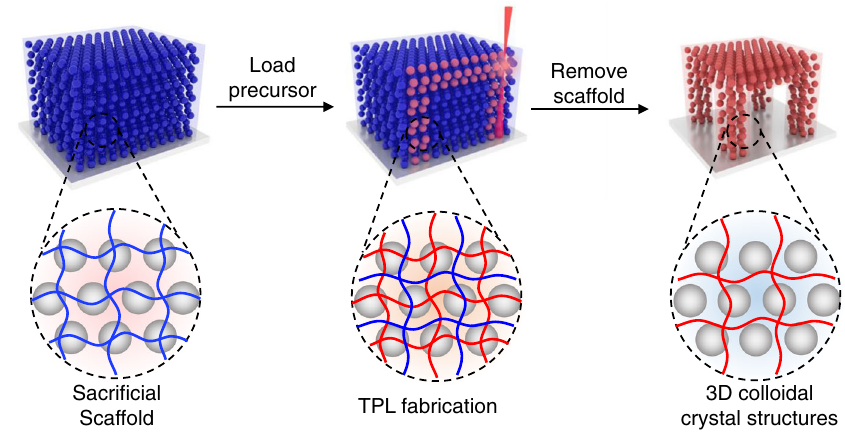
Fig. 1 | Schematic demonstration of the sacri fi cial-scaffold-mediated TPL process. The sacri fi cial scaffold containing a degradable hydrogel network and orderly-arranged nanoparticles is fi rst generated. Then hydrogel precursor